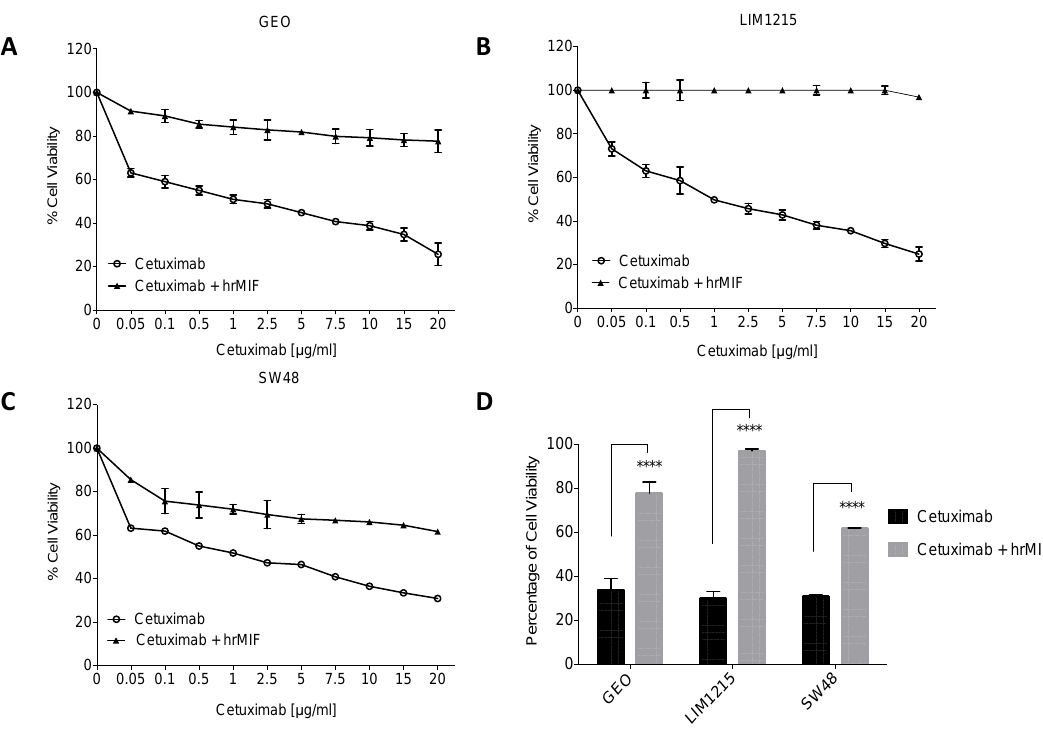
Figure 6. MIF triggers cetuximab-resistance in sensitive colon cancer cells. ( A – C ) Cell viability was evaluated by MTT staining on GEO ( A ), LIM1215 ( B ) and SW48 ( C ) cells following treatment for 72 h with increasing concentrations of cetuximab (range 0.05 – 20 µg/mL), alone and in combination with human recombinant MIF (hrMIF, 100 ng/mL). Results represent the median of three separate experiments, each performed in triplicate. ( D ) Graph bar showing the cell viability percentage of each cell line treated with cetuximab alone (20 µg/mL) and in combination with hrMIF (100 ng/mL). bars , standard deviation (SD); cetuximab versus cetuximab plus hrMIF; **** p ≤ 0.0001.